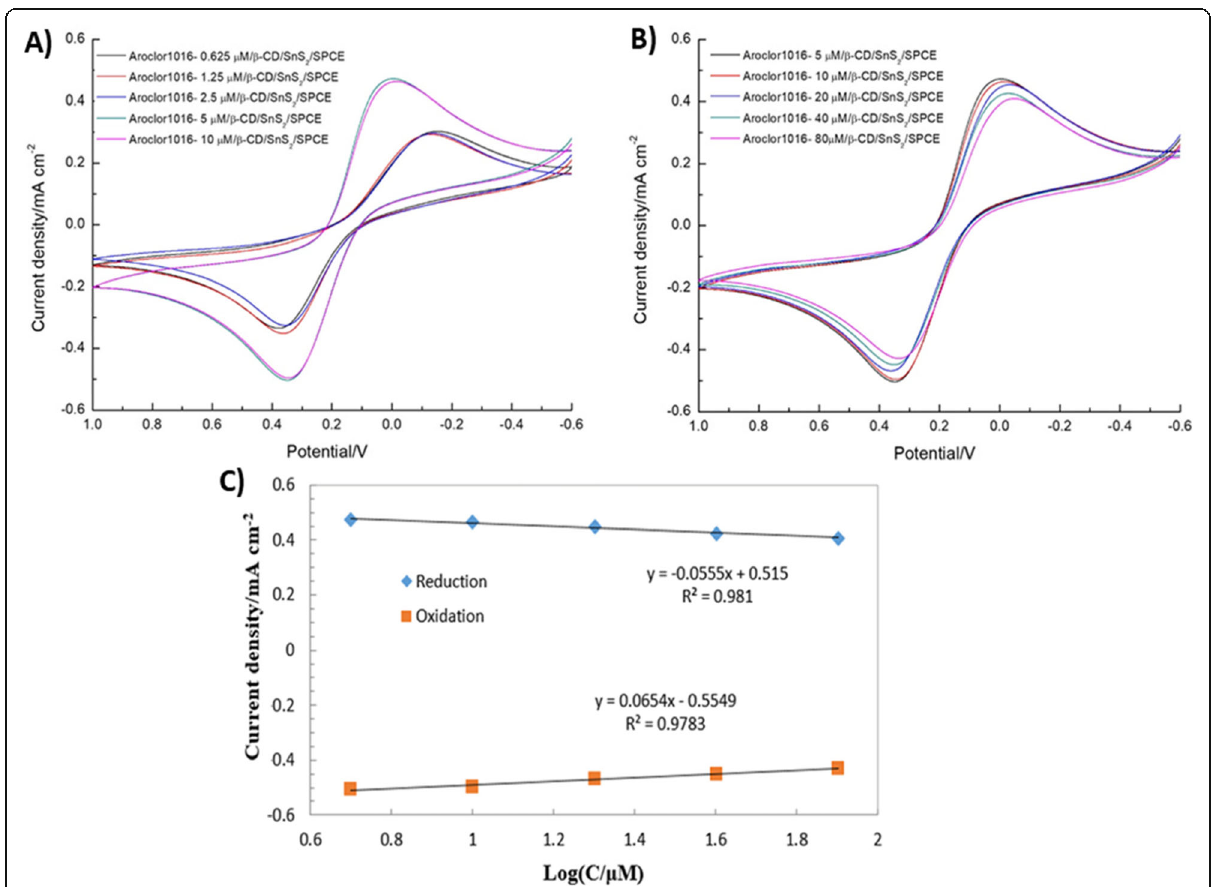
Fig. 7 CVs of the β -CD/SnS 2 /SPCE at a different concentrations of added PCBs (Aroclor 1016) from 0.625 to 2.5 μ M, b different concentrations of added PCBs (Aroclor 1016) from 5 μ M to 80 μ M. c The plot between the log concentration of PCBs (Aroclor 1016) and the anodic and cathodic peak current